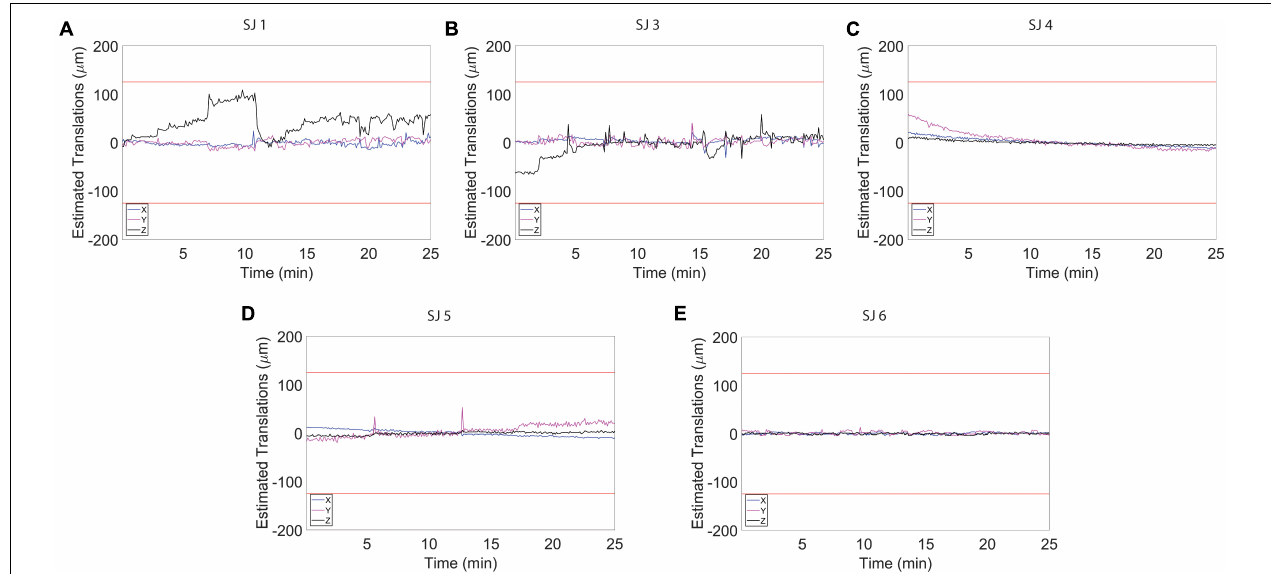
FIGURE 4 | Estimated motion levels for individual animals during the resting state functional magnetic resonance imaging (fMRI) acquisition. (A–E) Estimated motion levels (translations) for five individual animals. Low estimated motion parameter values, evident during the whole fMRI acquisition for all subjects, reflect a physiological and calm state of the habituated animals. The red lines represent 1/4 of the voxel